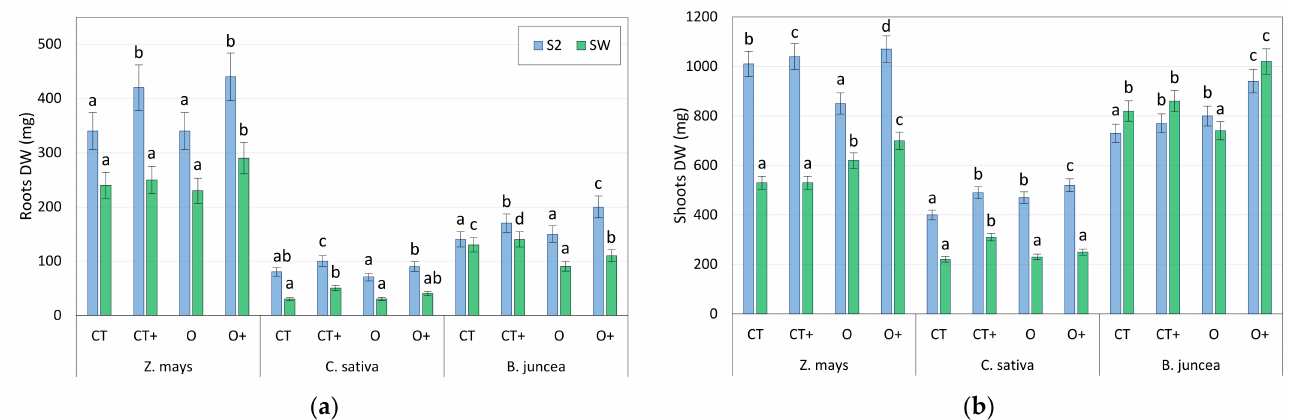
Figure 6. Dry weight (mg pot − 1 ) of ( a ) roots and ( b ) shoots of Z. mays , C. sativa, and B. juncea grown on soil control (CT) and As-contaminated soil treated with oxalate (O). The addition of PGPR bacteria (first set of isolates) is indicated with the “+” sign. Values are the mean of three replicates, and the error bars show the standard deviation. Values with different letters are significantly different at the 5% probability level (Tukey’s